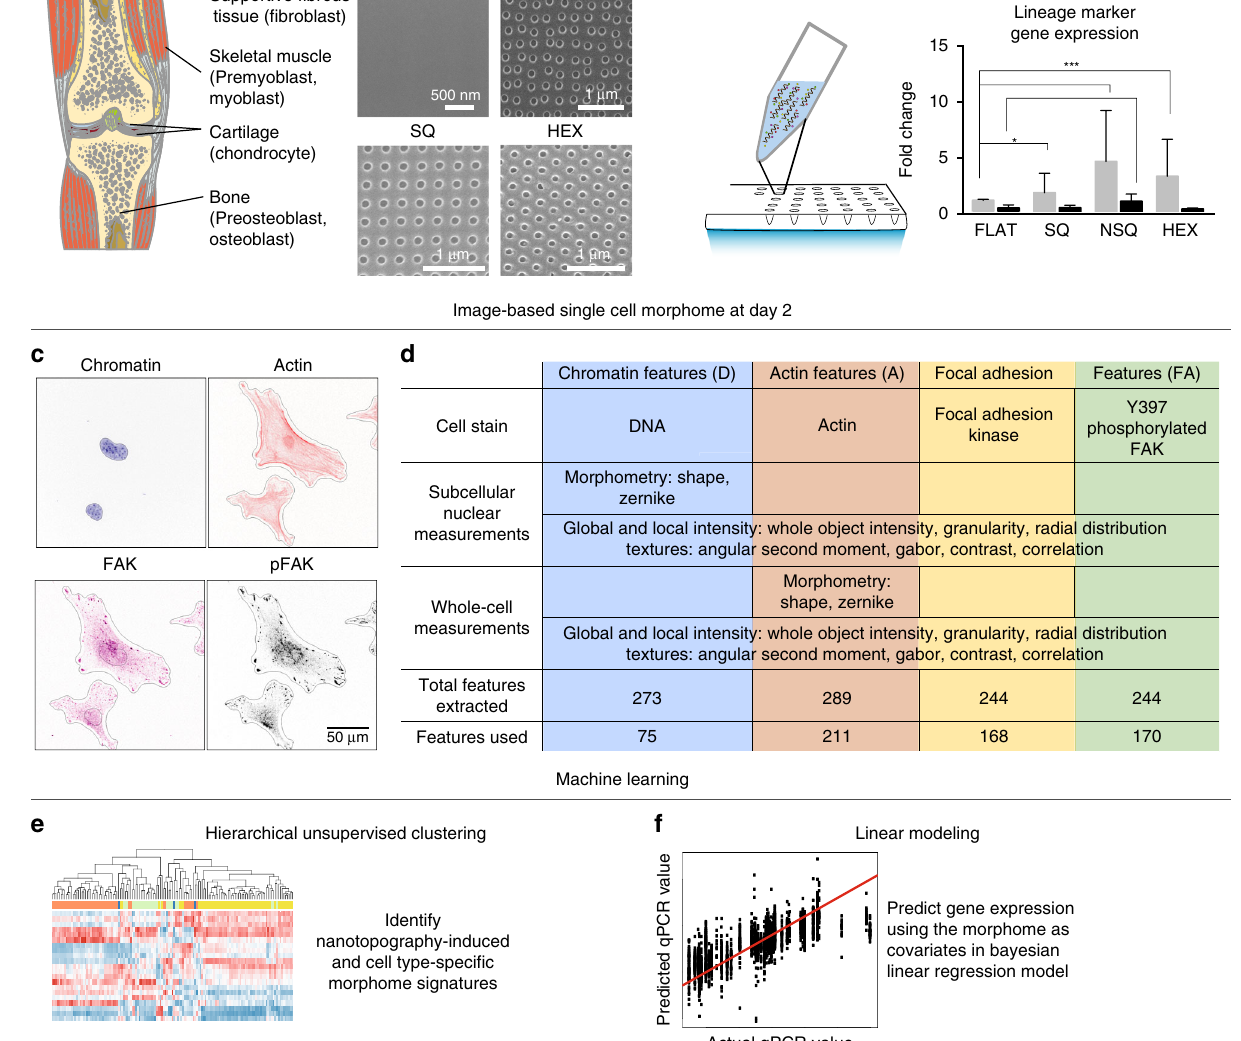
Fig. 1 The morphome relates gene expression and morphology changed by nanotopography. a Osteoblastic, myoblastic, chondroblastic, and fi broblastic cell lines were cultured on nanotopographies to obtain 24 combinations of cell type and topography. Precursor (pre-myoblast and pre-osteoblast) and lineage committed (myoblast and osteoblast) cells were from the same cell line, but with lineage committed cells cultured in the presence of inducers of myogenic or osteogenic differentiation. Image of musculoskeletal system obtained from Servier Medical Art under CC-BY 3.0. Servier Medical Art by Servier is licensed under a Creative Commons Attribution 3.0 Unported License (http://creativecommons.org/licenses/by/3.0/). b At day 7, lineage- speci fi c gene expression induced by nanotopography was measured using population-based quantitative polymerase chain reaction (QPCR). c , d Image- based cell pro fi ling. At day 2, various measures of chromatin (blue), actin (red), focal adhesion kinase (FAK, yellow), and phosphorylated FAK (pFAK, green) were obtained from images of single cells. Collectively, multivariate dataset containing single-cell measures of focal adhesions, the cytoskeleton, and chromatin is referred to as the “ morphome ” . c Representative images of cells stained against different cellular aspects. Black lines show the cell and nucleus outlines, from which morphology measurements were extracted. Cell and nucleus outlines were obtained from the actin and chromatin images, respectively. d Morphome features extracted from 4 stains across single cells. e , f Machine learning for data-driven exploration and model building using the morphome. e Hierarchical clustering uncovered distinct patterns that delineate cell type and nanotopography within the morphome. f Bayesian linear regression created a predictive model that related the morphome to gene